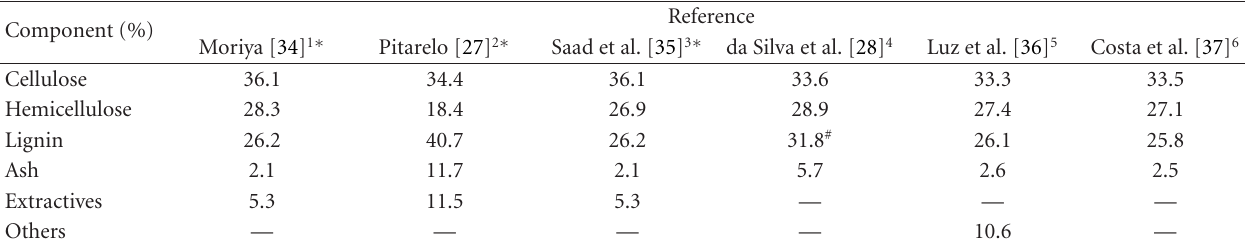
Table 3: Chemical composition (% w/w, dry basis) of Brazilian SS reported in the literature.